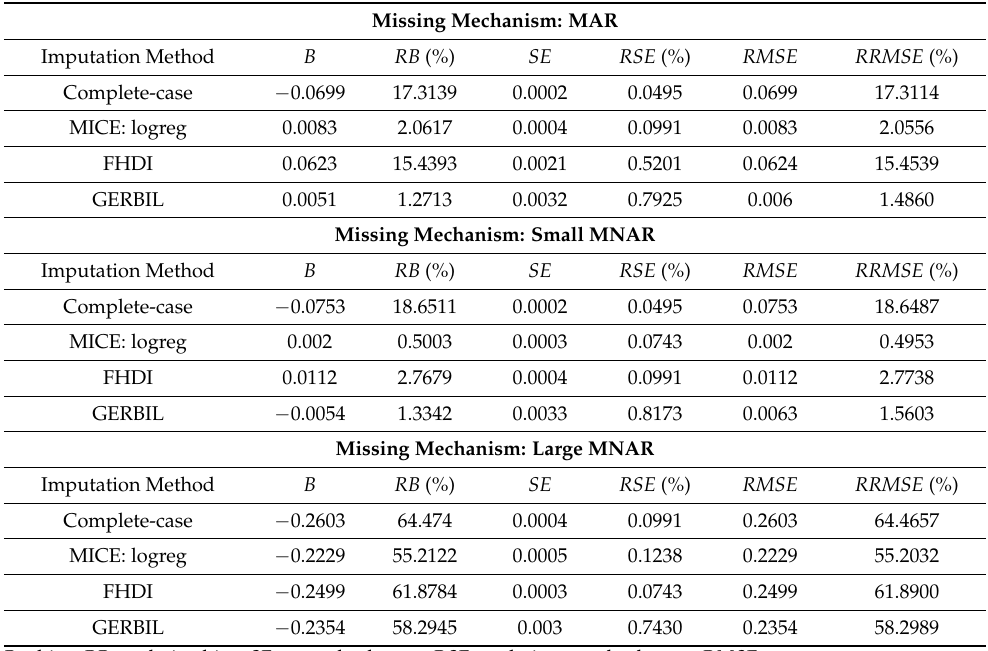
Table 4. Summary of Simulation Results for Proportion of NHANES Variable “Having High Blood Pressure”.